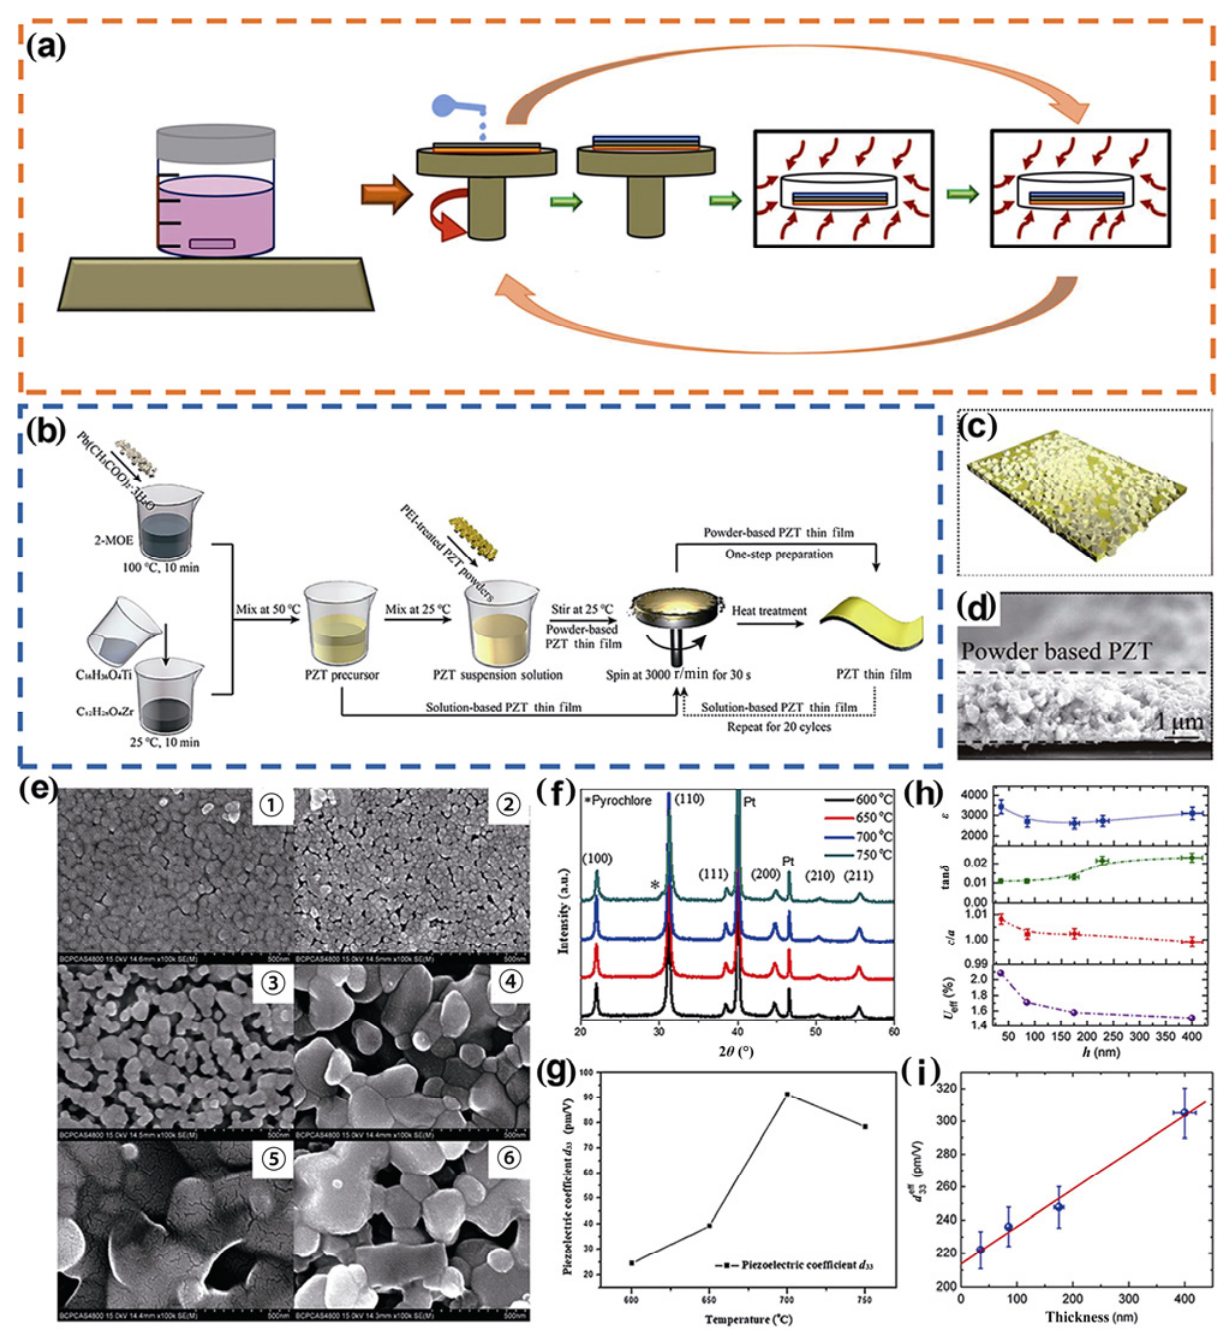
Fig. 3 (a) Schematic diagram of sol–gel process. (b) Modified sol − gel preparation process of PZT thin films. (c) Morphology and (d) cross-sectional SEM image of powder-based PZT film. (e) SEM images of V-doped ZnO films: ① annealed at 600 ℃ for 45 min, ② annealed at 600 for 45 min followed by annealed at 650 for 30 min, ℃ ℃ ③ annealed at 600 for 45 min ℃ followed by annealed at 700 for 30 min, and ( ℃ ④ , ⑤ , and ⑥ ) annealed at 600 for 45 min followed by anneal ℃ ed at 750 ℃ d of PZT films at different annealing temperatures from 600 to for 30, 40, and 50 min, respectively. (f) XRD patterns and (g) 33 750 . (h) Dependence of ℃ ε at 1 kHz, tan δ at 1 kHz, c / a , and U eff on BCTZ film thickness ( h ). (i) Variation of effective piezoelectric coefficient ( eff 33